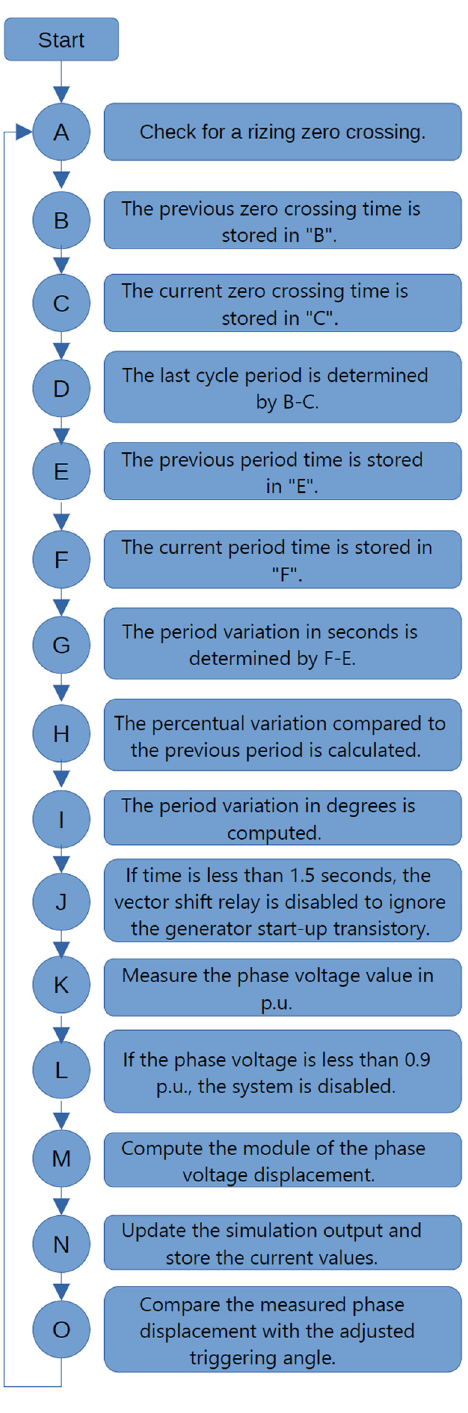
Figure 7: Flowchart of the vector shift relay implemented in